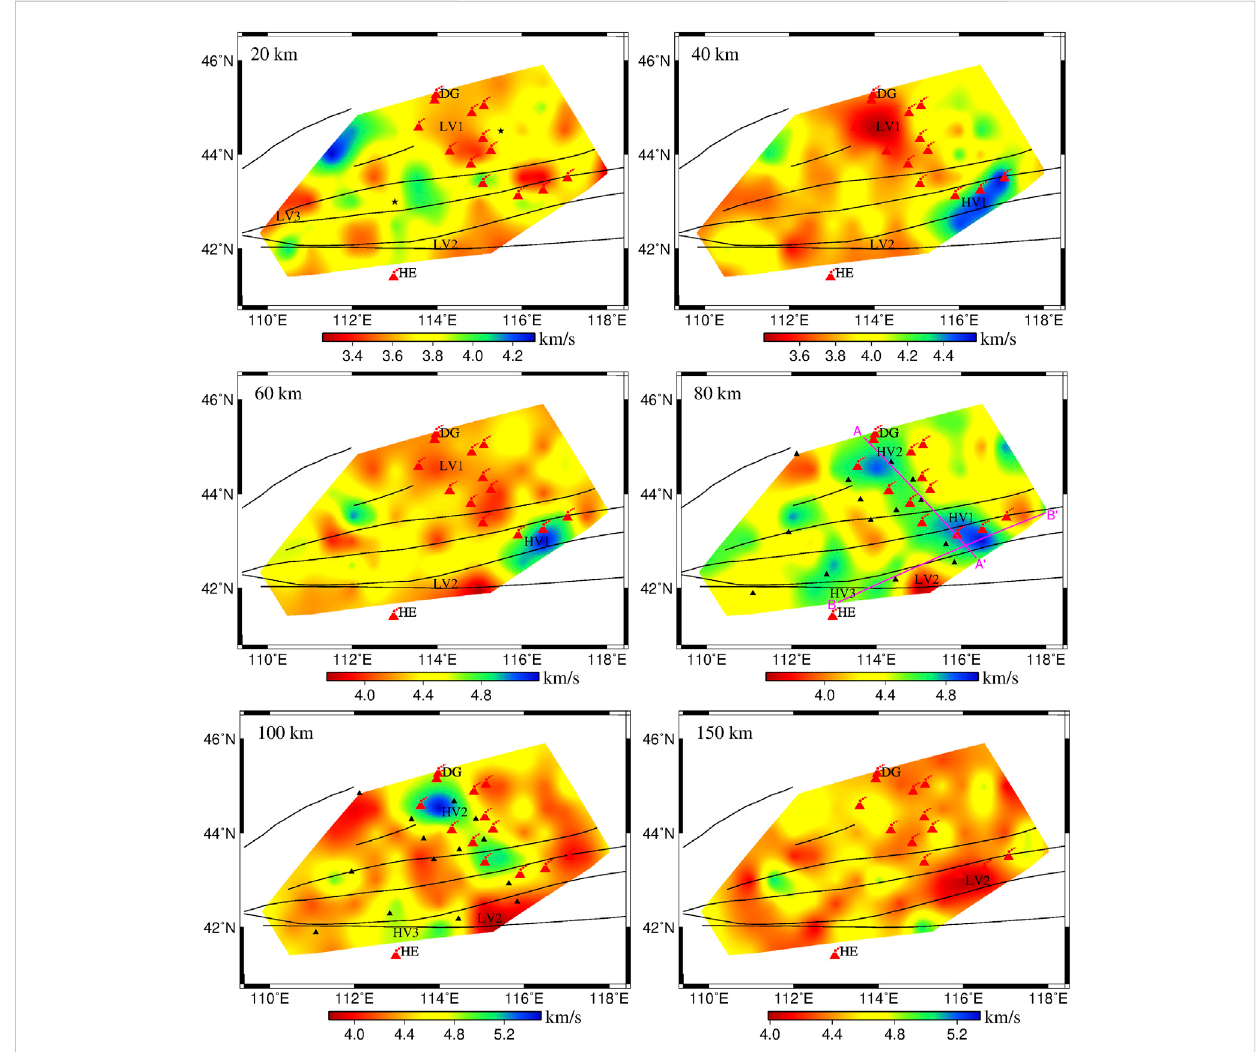
FIGURE 8 S-wave velocity pro fi les at different depths in the study region. On 80 km and 100 km depth pro fi le, black triangles represent XKS invalid split result (Qiang and Wu, 2019). On 80 km depth pro fi le, the pink straight line represents the position of pro fi les AA ‘ and BB ’ . The red triangles are the locations of the volcanoes, in which DG is the Dariganga volcano, HE is the Honggeertu volcano, and the rest red triangles are the Abaga volcano group. The black fi ve-pointed stars on 20 km depth pro fi le are the speci fi c locations of the two grid points used in Figure